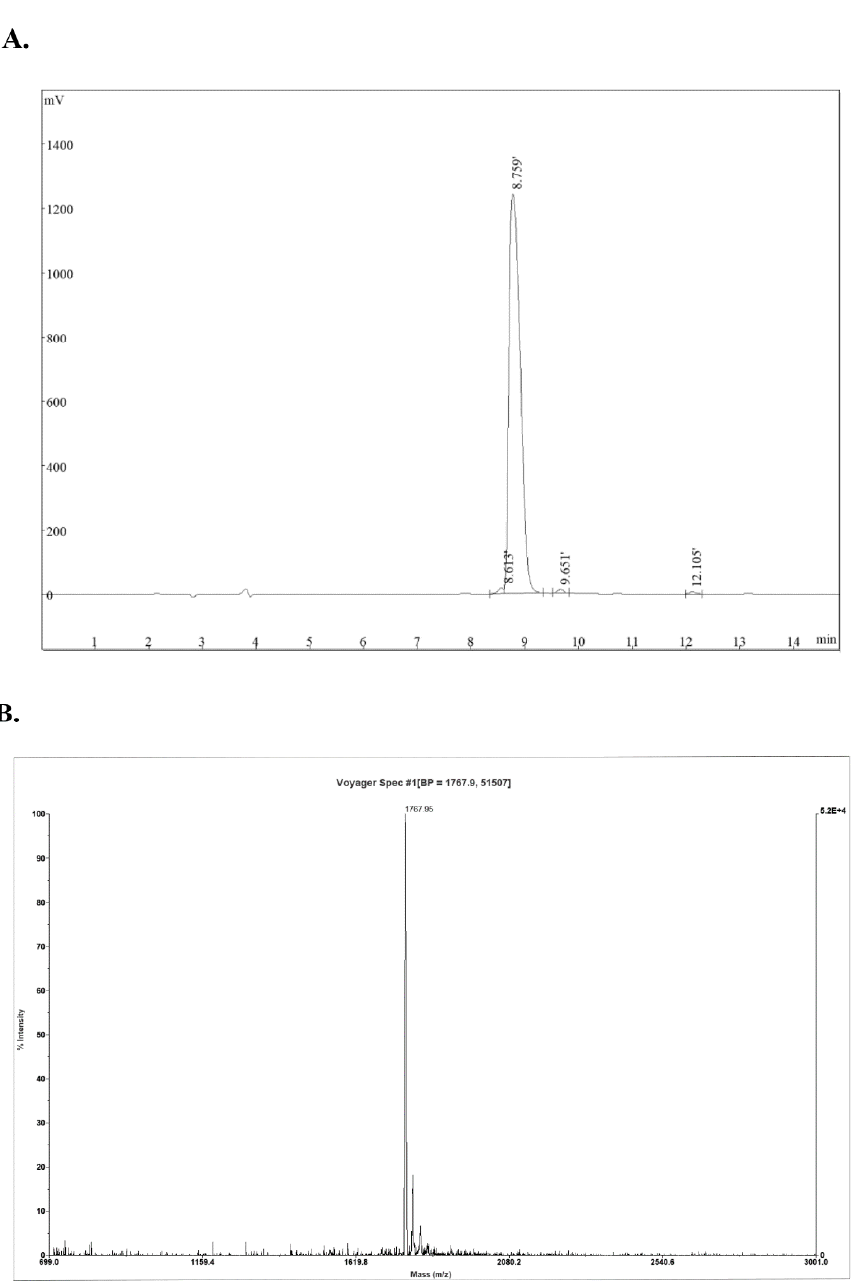
Figure 1. Reverse phase high performance liquid chromatography (RP-HPLC) and matrix-assisted laser desorption/ionization time-of-flight mass spectrometry (MALDI-TOF-MS) analysis of L. vannamei hemocyanin-derived antimicrobial peptide B11. ( A ) Chromatographic profile of purified peptide B11 products, ( B ) MALDI-TOF-MS spectra of purified peptide B11.